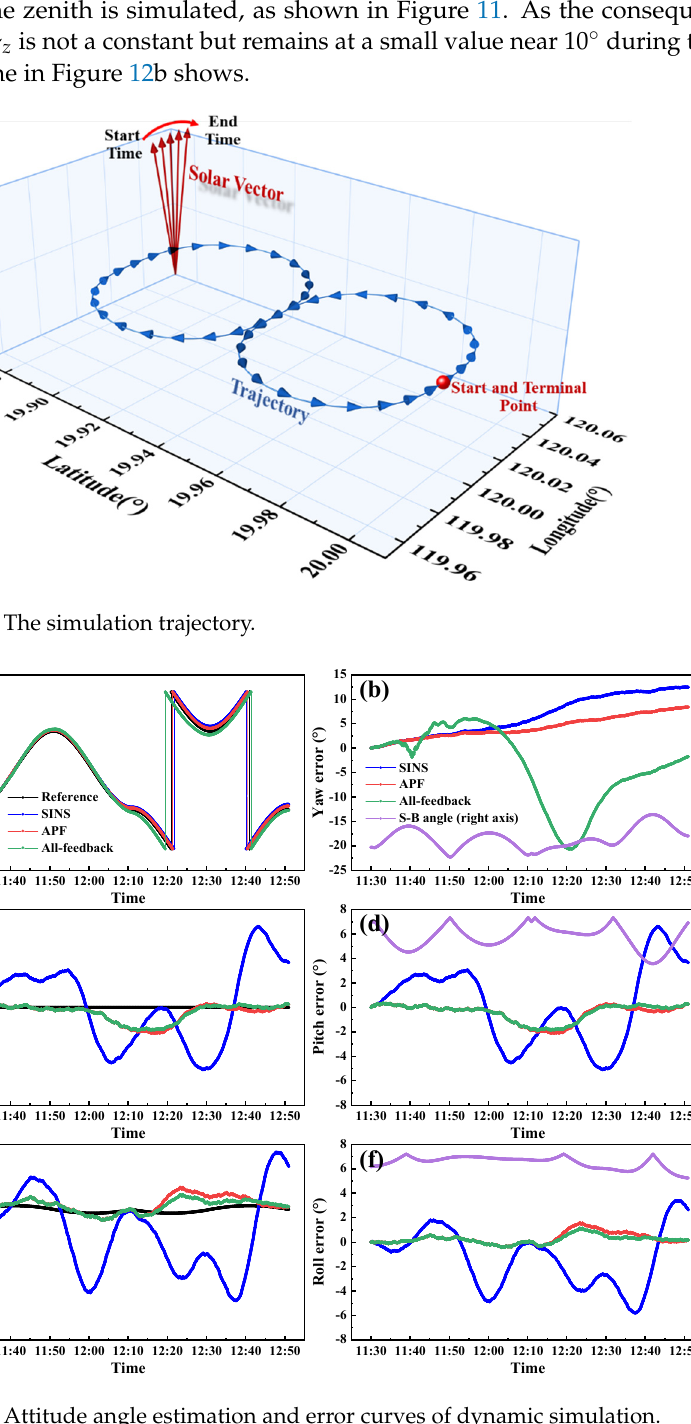
Figure 12. Attitude angle estimation and error curves of dynamic simulation.